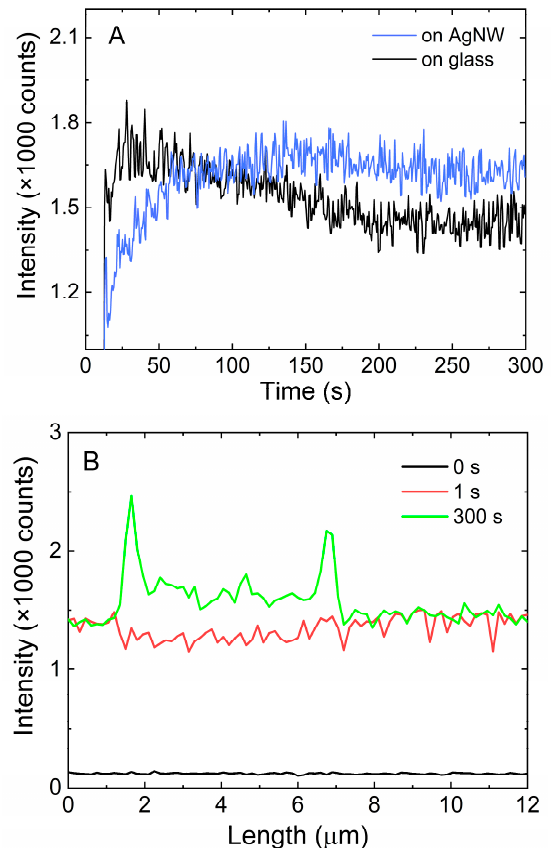
Figure 7. ( A ). Fluorescence intensity in time measured along the AgNWs (blue) and for background signal level on glass (black), ( B ). Time profiles of fluorescence intensity of mCherry along a single